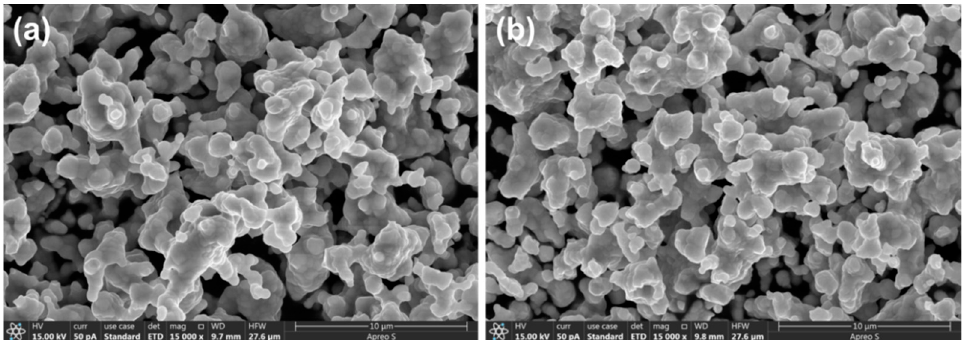
Figure 5. SEM images of surface microstructure of SFMO perovskite powders before ( a ) and after ( b ) reduction in pure H 2 at 800 °C for 2 h.